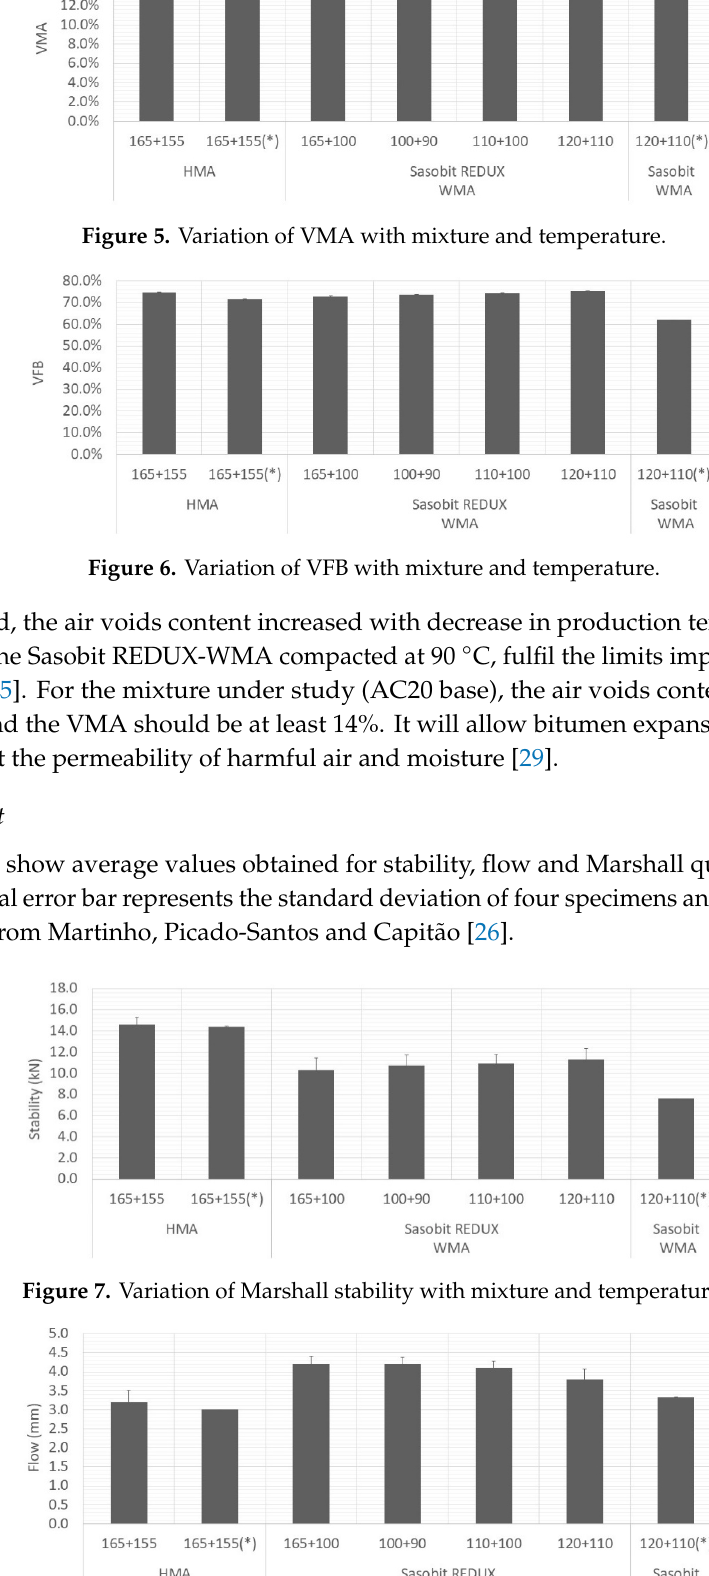
Figure 9. Variation of Marshall quotient with mixture and temperature. Portuguese specifications impose limits on the values of these properties. For the mixture under study (AC20), the stability must be in the range 7.5–15 kN, the flow in the range 2–4 mm and the Marshall quotient should be at least 2 kN/mm [25]. The WMA yielded stability values lower than the HMA but above the minimum limit (7.5 kN). In relation to the flow, some values are just above the upper limit (4 mm) and above the ones obtained using the additive Sasobit [26], which may be explained by the bitumen dosage used, 5.0% against the 4.5% used in Martinho, Picado-Santos and Capitão [26]. Nevertheless, the Marshall quotients are all higher than 2 kN/mm. For the three compaction temperatures tested (90, 100 and 110 °C), the results were very similar. Therefore, looking for the volumetric and the Marshall properties, the Sasobit REDUX additive has the potential to lower the production temperature of WMA at 20 °C. 4.3. Compactability Test Figure 10 presents the development of the degree of compaction with the number of gyrations. The parameters, C 1 and K, obtained by fitting Equation (3) to the compaction curves are presented in Figures 11 and 12, respectively. The vertical error bar represents the standard deviation of four specimens. In Figure 12, it is also possible to see the squared-correlation values which are in the range 94%–98%.